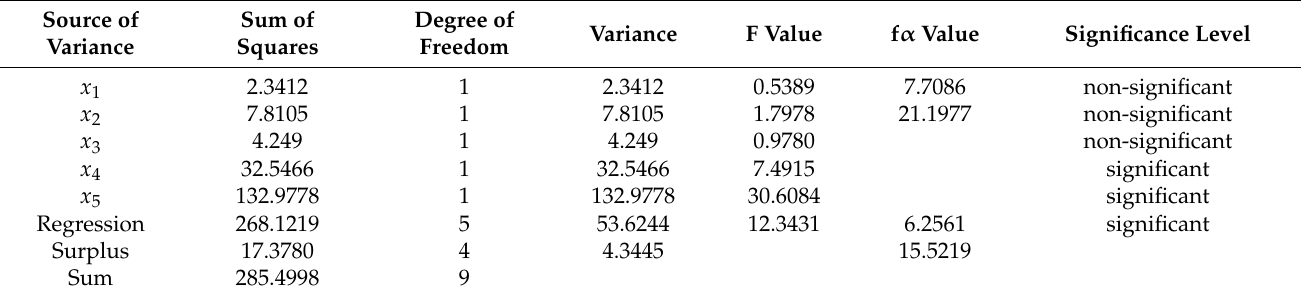
Table 7. Variance analysis results of the influence of various factors on the recovery rate of residual film after soil